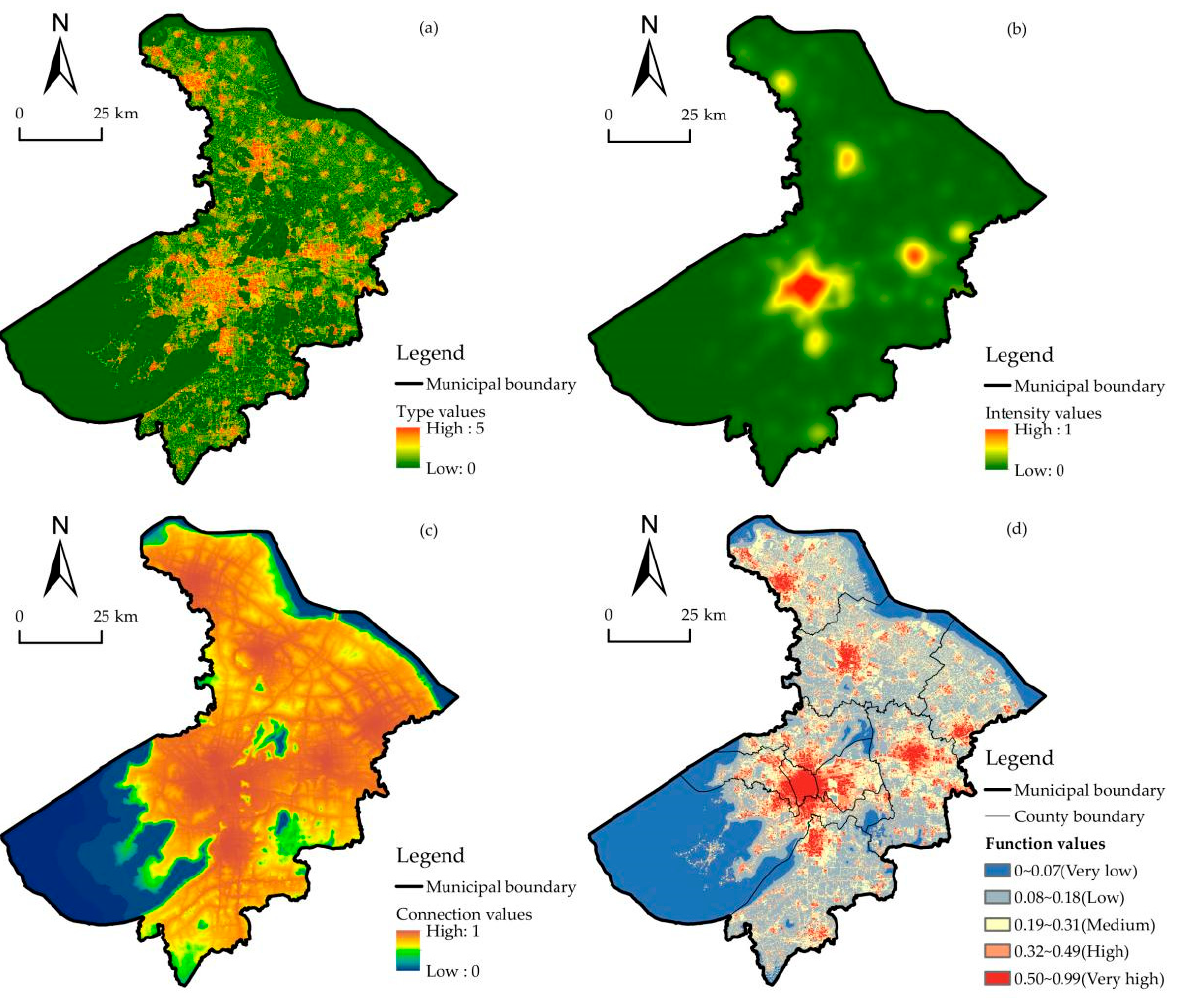
Figure 4. Functional level of living space: ( a ) Spatial type; ( b ) Spatial intensity; ( c ) Spatial connection; ( d ) Spatial function.